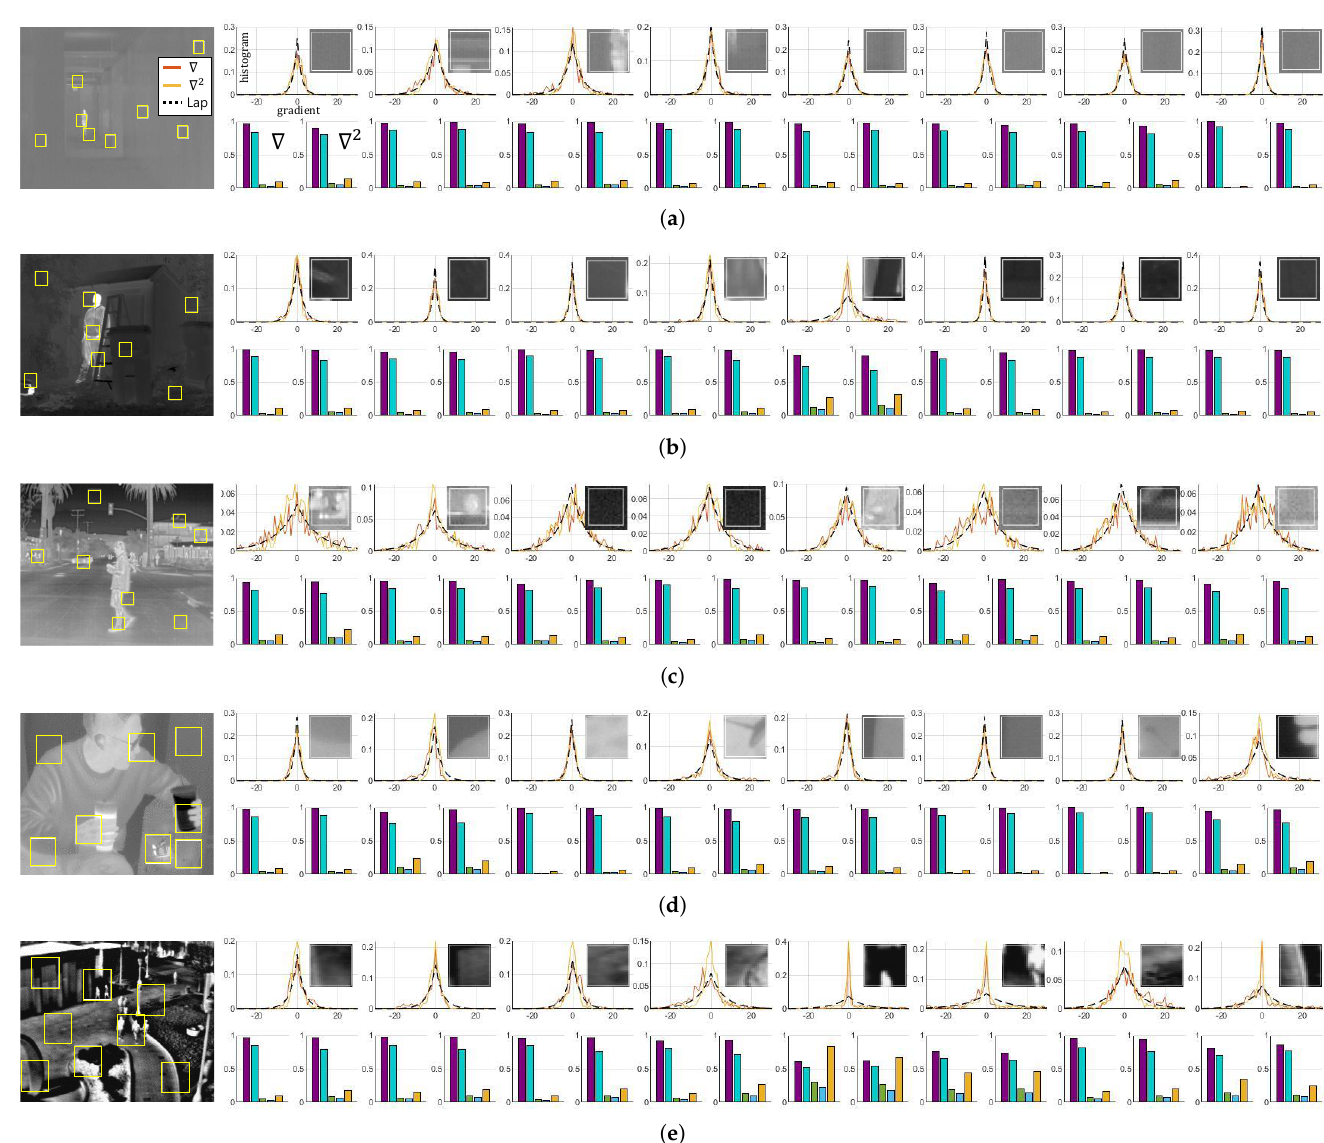
Figure 4. Analysis of the patch-based Gradient statistics. The patches (of size 21 × 21) are randomly sampled, and the observed and estimated distribution of high frequencies using ∇ and ∇ 2 have been analyzed with the measures of Table 1. All the LWIR images in the datasets have demonstrated similar results; most of the patches satisfy our hypothesis.